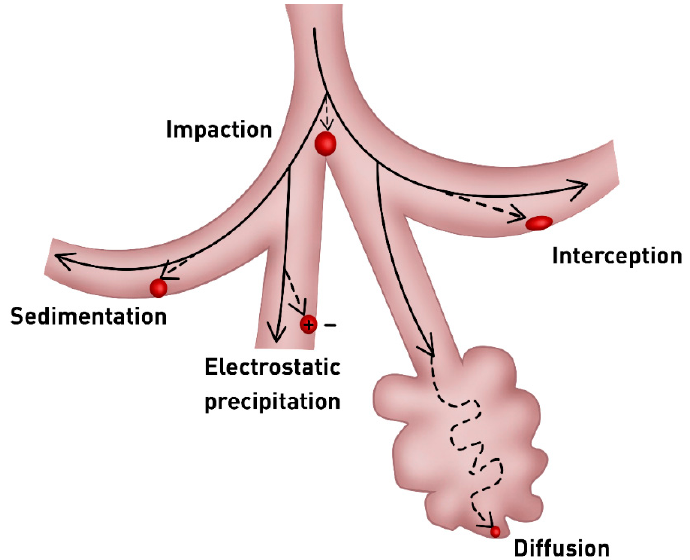
Figure 2. Particle deposition mechanisms into the respiratory tract. The solid line represents the air flow, and the dashed line represents the particles trajectory.